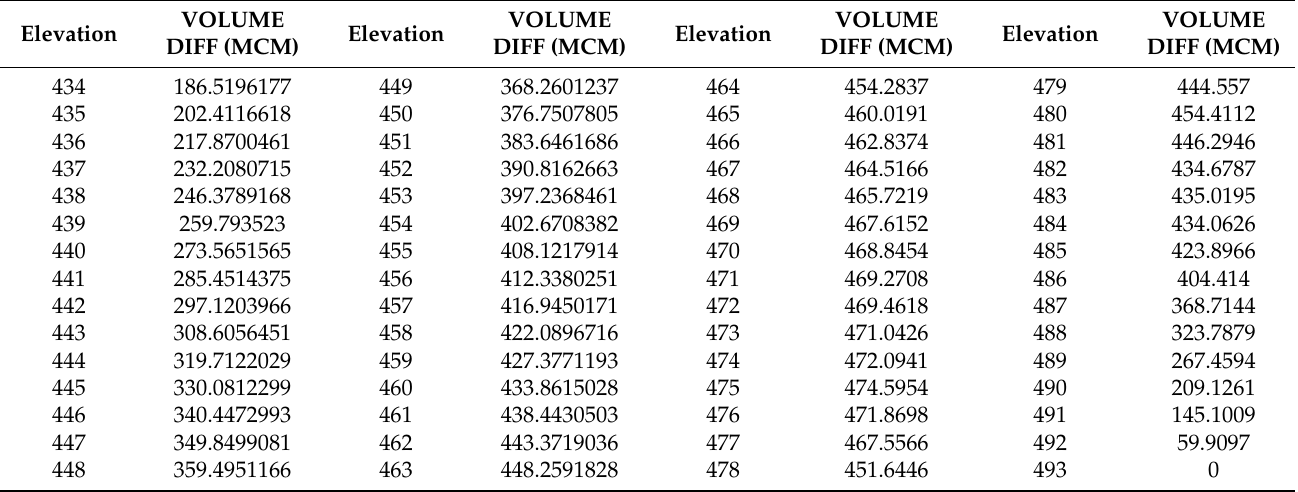
Table A2. The amount of the reservoir sedimentation gained for the period between November 1961 and 2 May 2008, within the Darbandikhan [112].